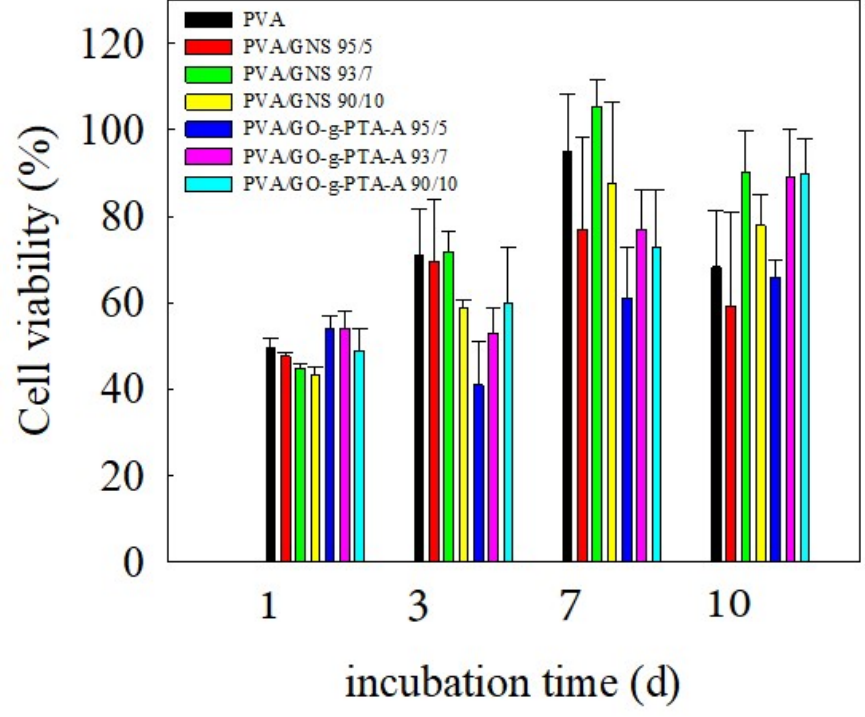
Figure 10. Cell viability of the treated 3T3 cells for the neat PVA, PVA/GNS, and PVA/GO-g-PTA-A composite nanofiber mats after 1, 3, 7, and 10 days of incubation.